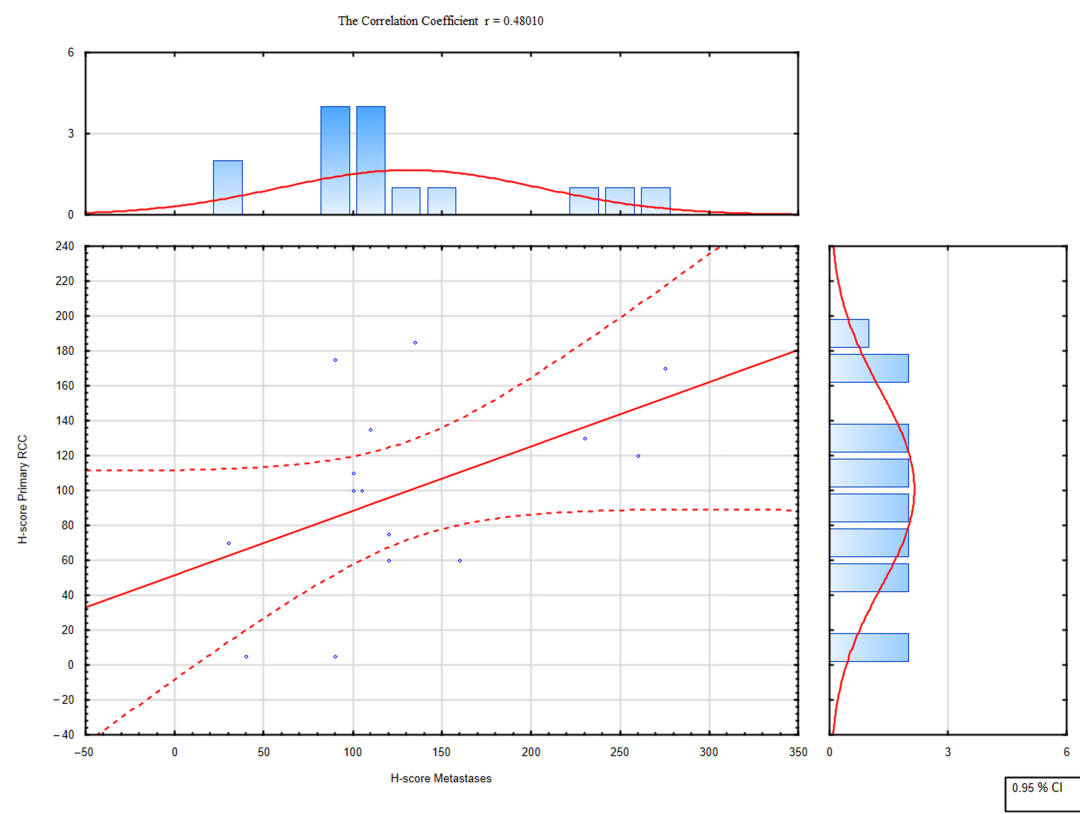
Figure 3. Correlation between TOLLIP expression in primary and metastatic RCC.